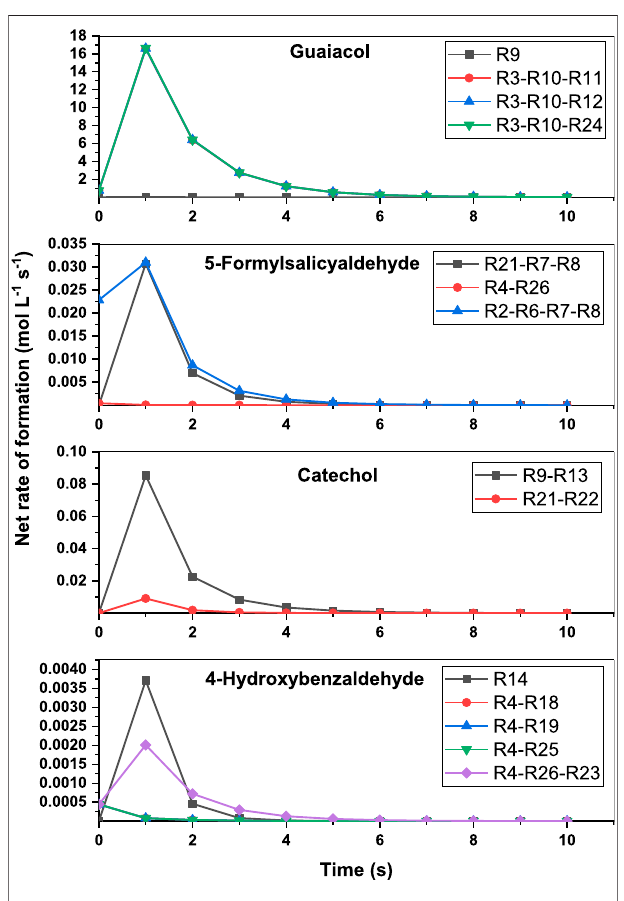
FIGURE 8 | Net rate analysis for the formation of guaiacol, 5- formylsalicyaldehyde, catechol and 4-hydroxybenzaldehyde at 800 ° C.